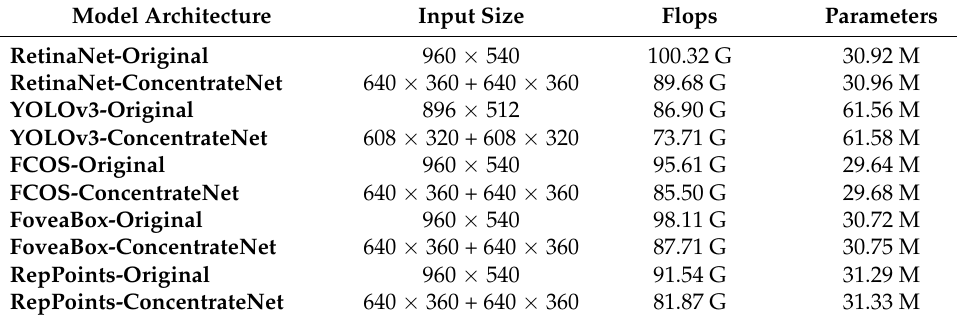
Table 5. Comparison in model complexity and parameters.